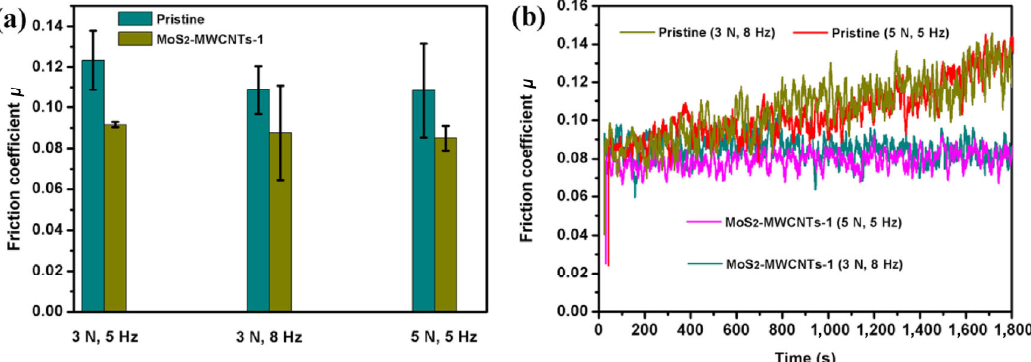
Fig. 8 Friction coefficients of the pristine and MoS 2 -MWCNT-1 reinforced polyurethane composite coatings under different applied loads and sliding